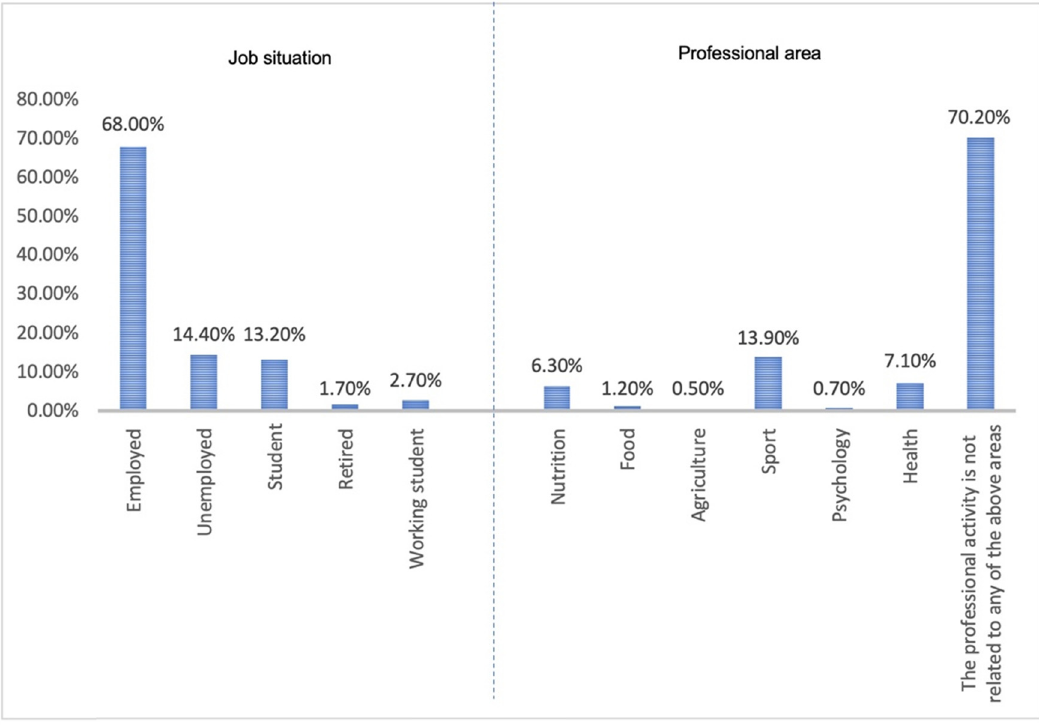
Figure 2: Demographical data: job situation, professional area.